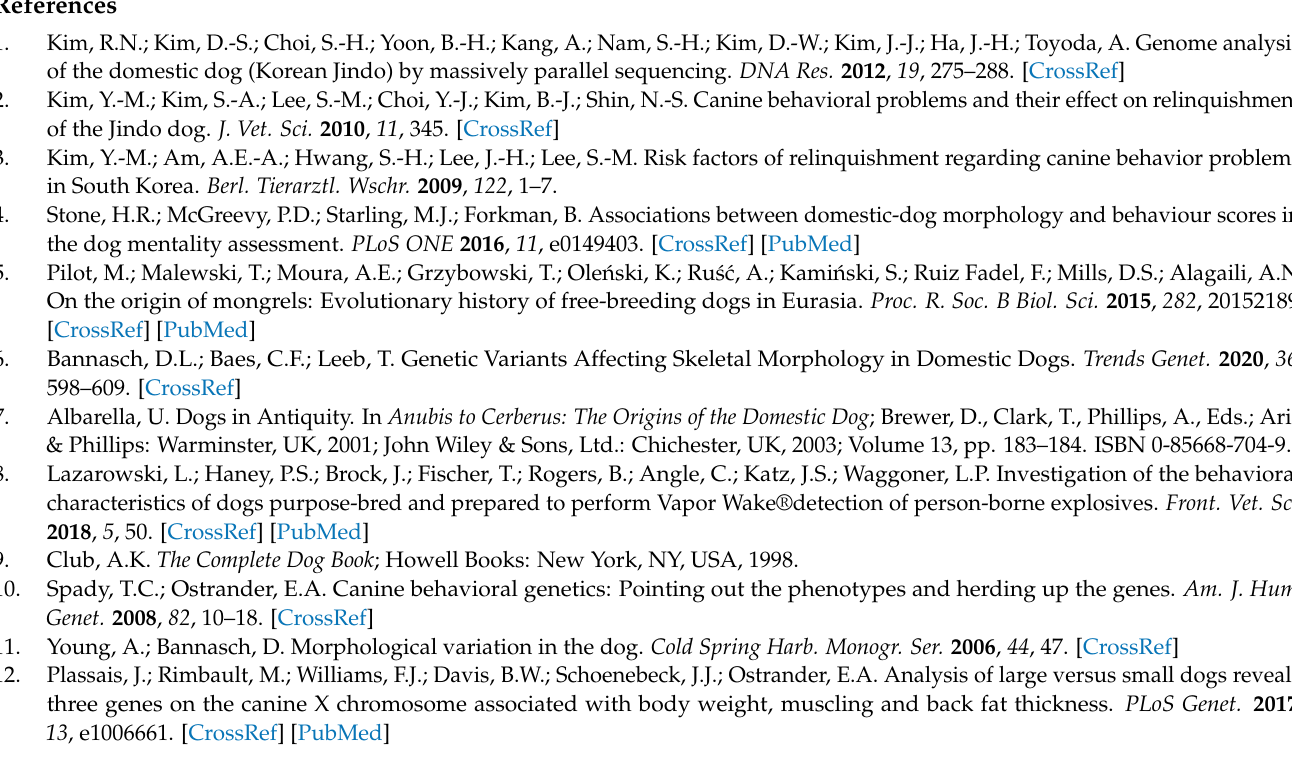
Table S1: List of all SNPs ( p < 0.01) associated with height, length, LHR and body-weight that were used for gene-set and pathway analysis. Table S2: List of all Gene Ontology and KEGG